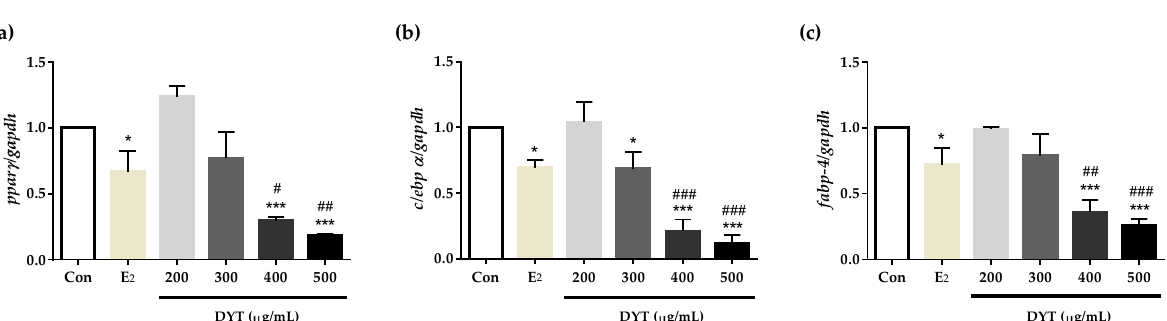
Fig. 3 Effect of DYT on the expression of adipogenic‑related mRNA in differentiated 3T3‑L1 cells. The relative expression levels of PPAR γ ( a ), C/ EBP α ( b ), and FABP4 ( c ) mRNA by qRT‑PCR analysis. The data were normalized using the GAPDH as internal control. The results are presented as the mean SD of three independent experiments. * p < 0.05, *** p < 0.001 vs. control., # p < 0.05, ## p < 0.01, ### p < 0.001 vs. E ±